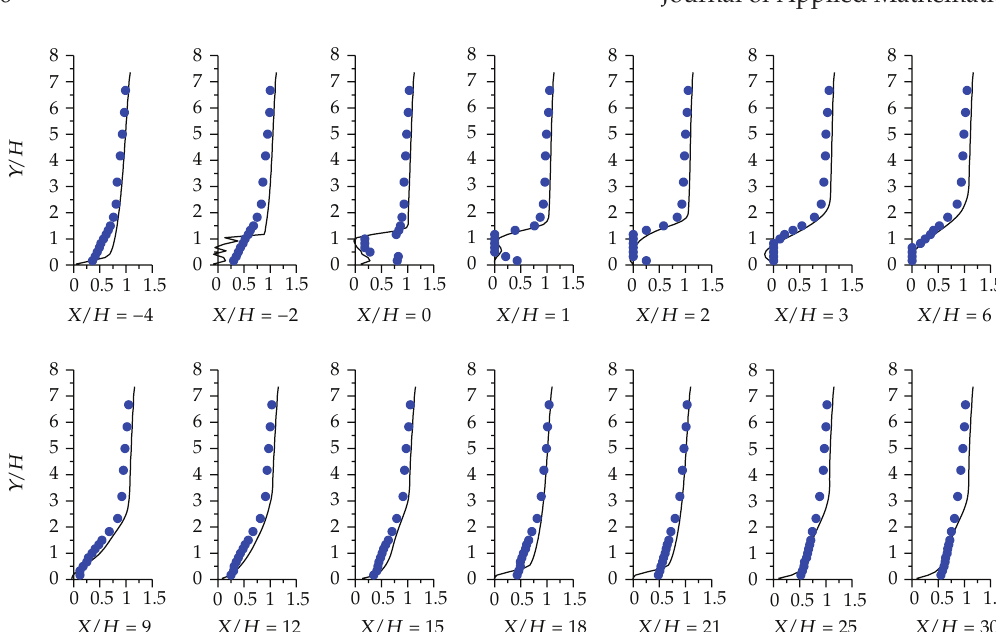
Figure 5: Comparison between calculated results and measured data of mean streamwise velocity profiles around the nonuniform porous fence (cid:7) ε U (cid:3) 0% and ε L (cid:3) 30% (cid:8) : (cid:7) full line (cid:8) numerical simulation, (cid:7) (cid:2) (cid:8)